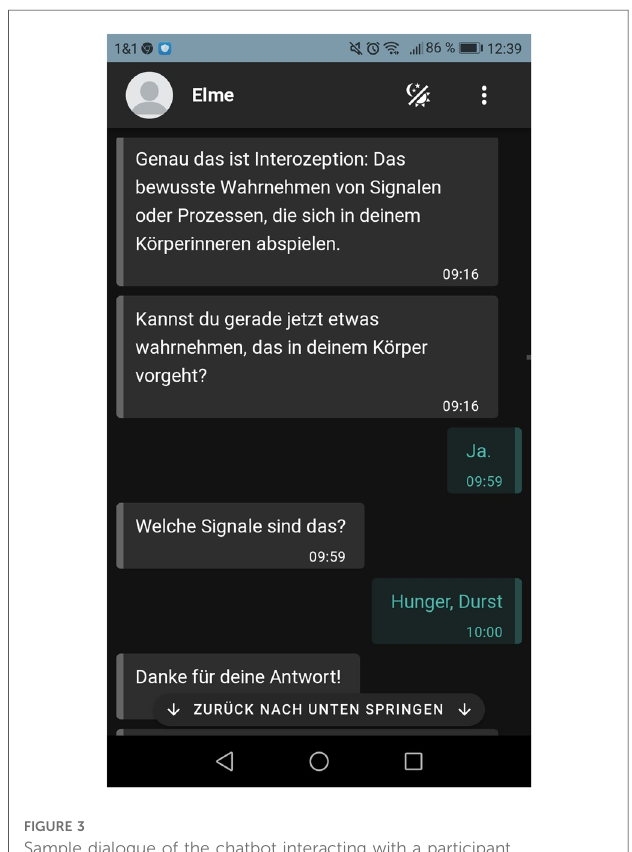
FIGURE 3 Sample dialogue of the chatbot interacting with a